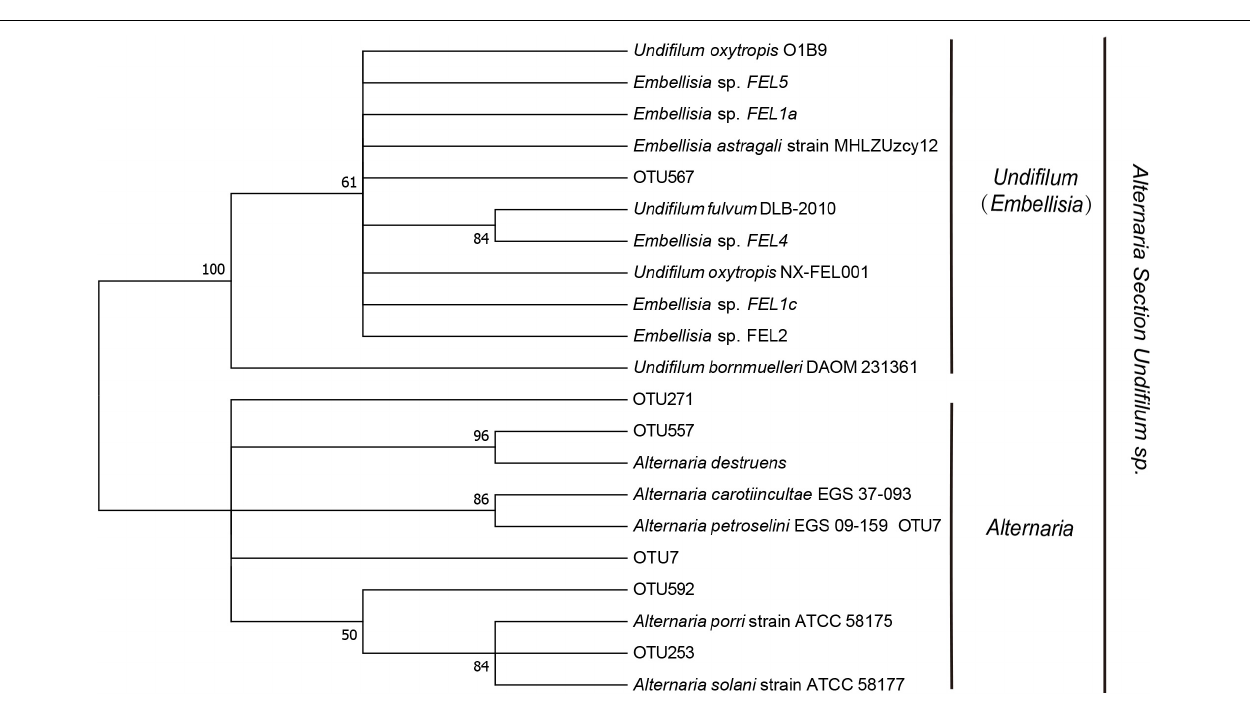
FIGURE 6 | Neighbor-Joining (NJ) phylogenetic tree based on ITS sequence. The number on the evolution tree represents the self-test support